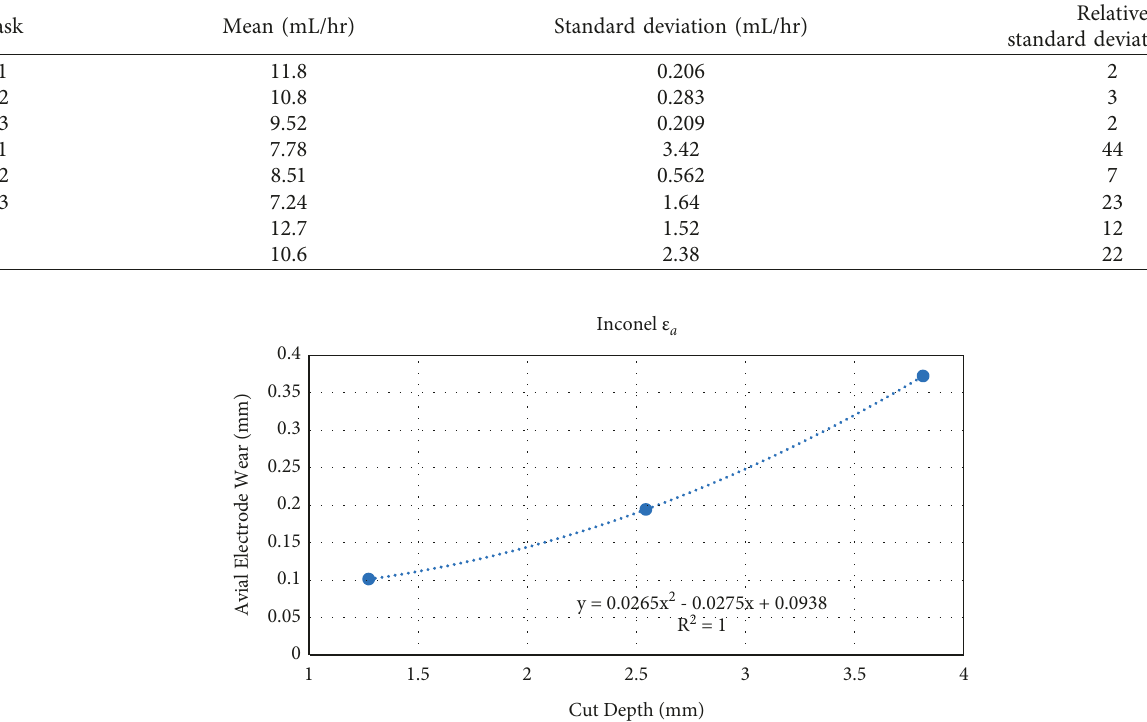
Table 6: Statistical analysis of _ μ .